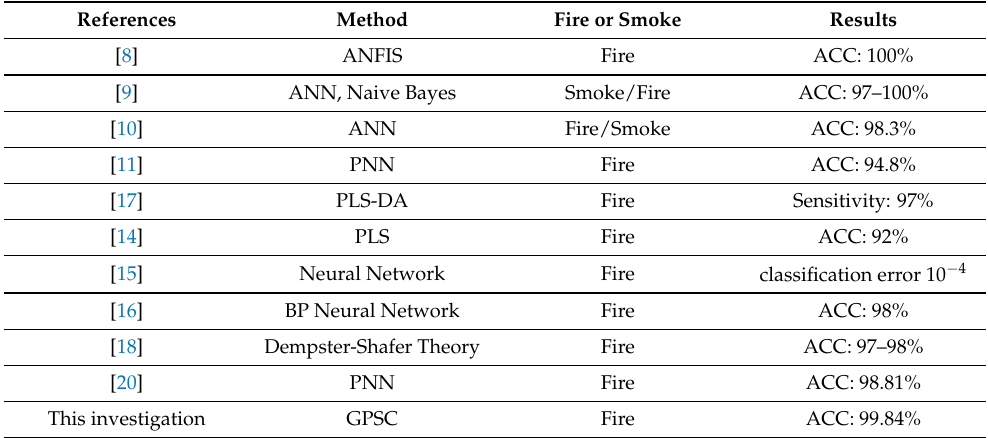
Table 9. The comparison of the obtained results with previous investigations discussed in the Introduction